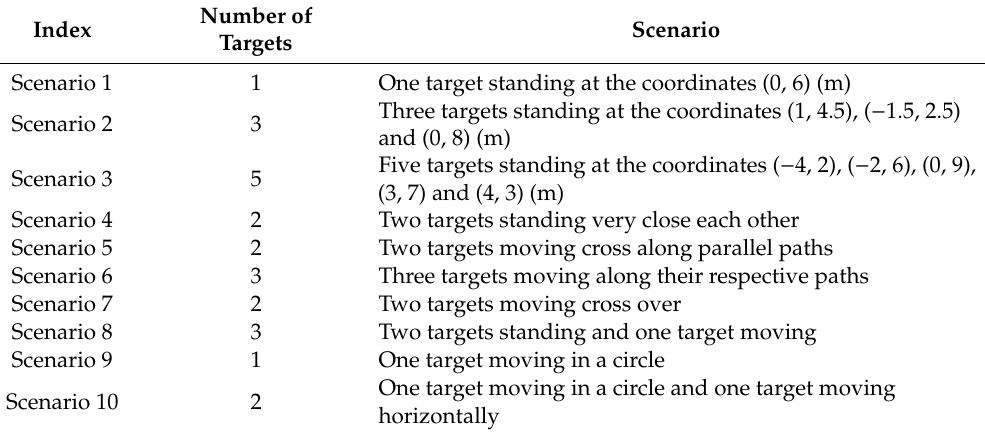
Table 3. Experimental